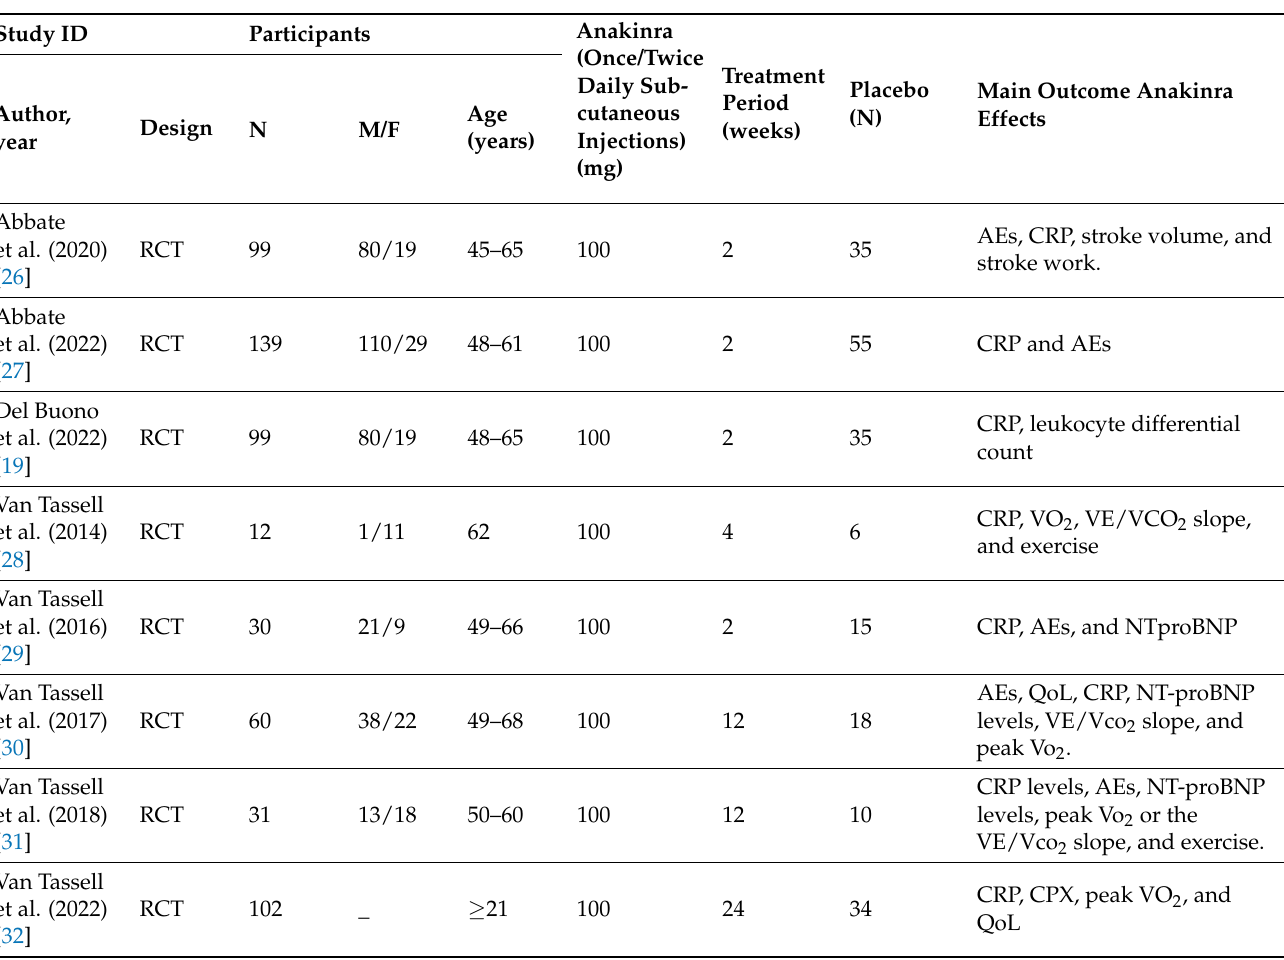
Table 2. Study characteristics. NOTE: RCT, randomized controlled trial; CRP-C, reactive protein; Vo2, peak oxygen consumption; VE/Vco2, minute ventilation–carbon dioxide production slope; NT, proBNP-N-terminal pro-B-type natriuretic peptide; AEs, adverse events; QoL, quality of life; CPX, cardiopulmonary exercise